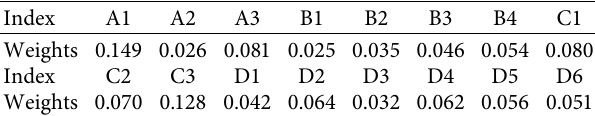
Table 1: Calculation results of combination weight